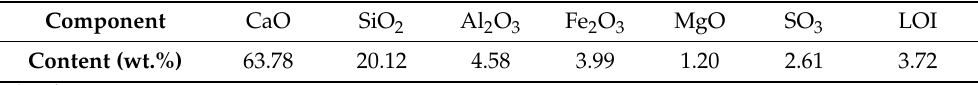
Table 1. Oxide composition of Portland